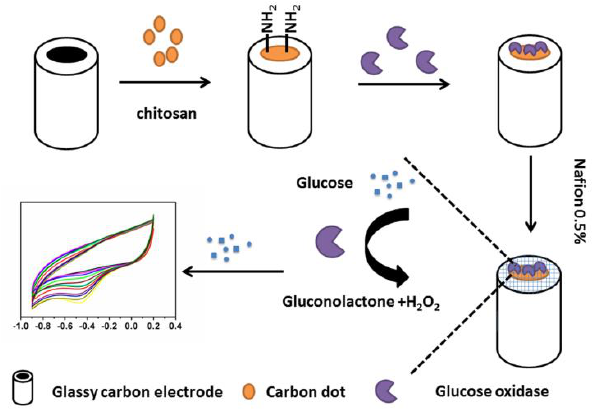
Figure 1. Schematic of the N-doped CDs based electrochemical glucose biosensor.